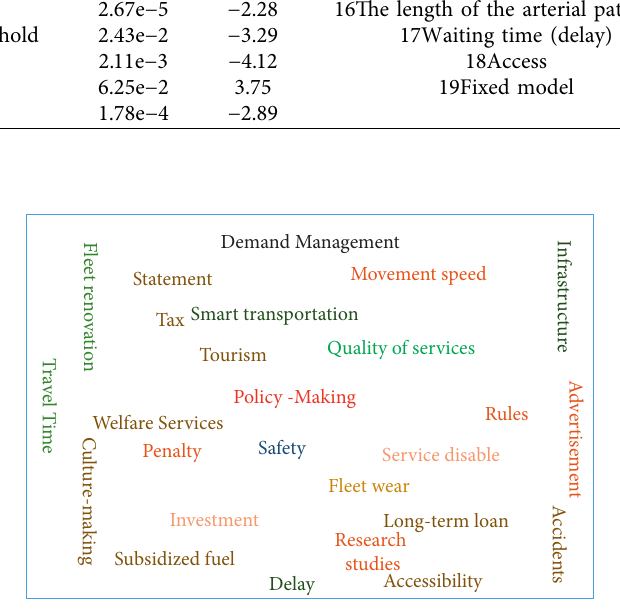
Figure 4: Word cloud map for the answers of the respondents to the